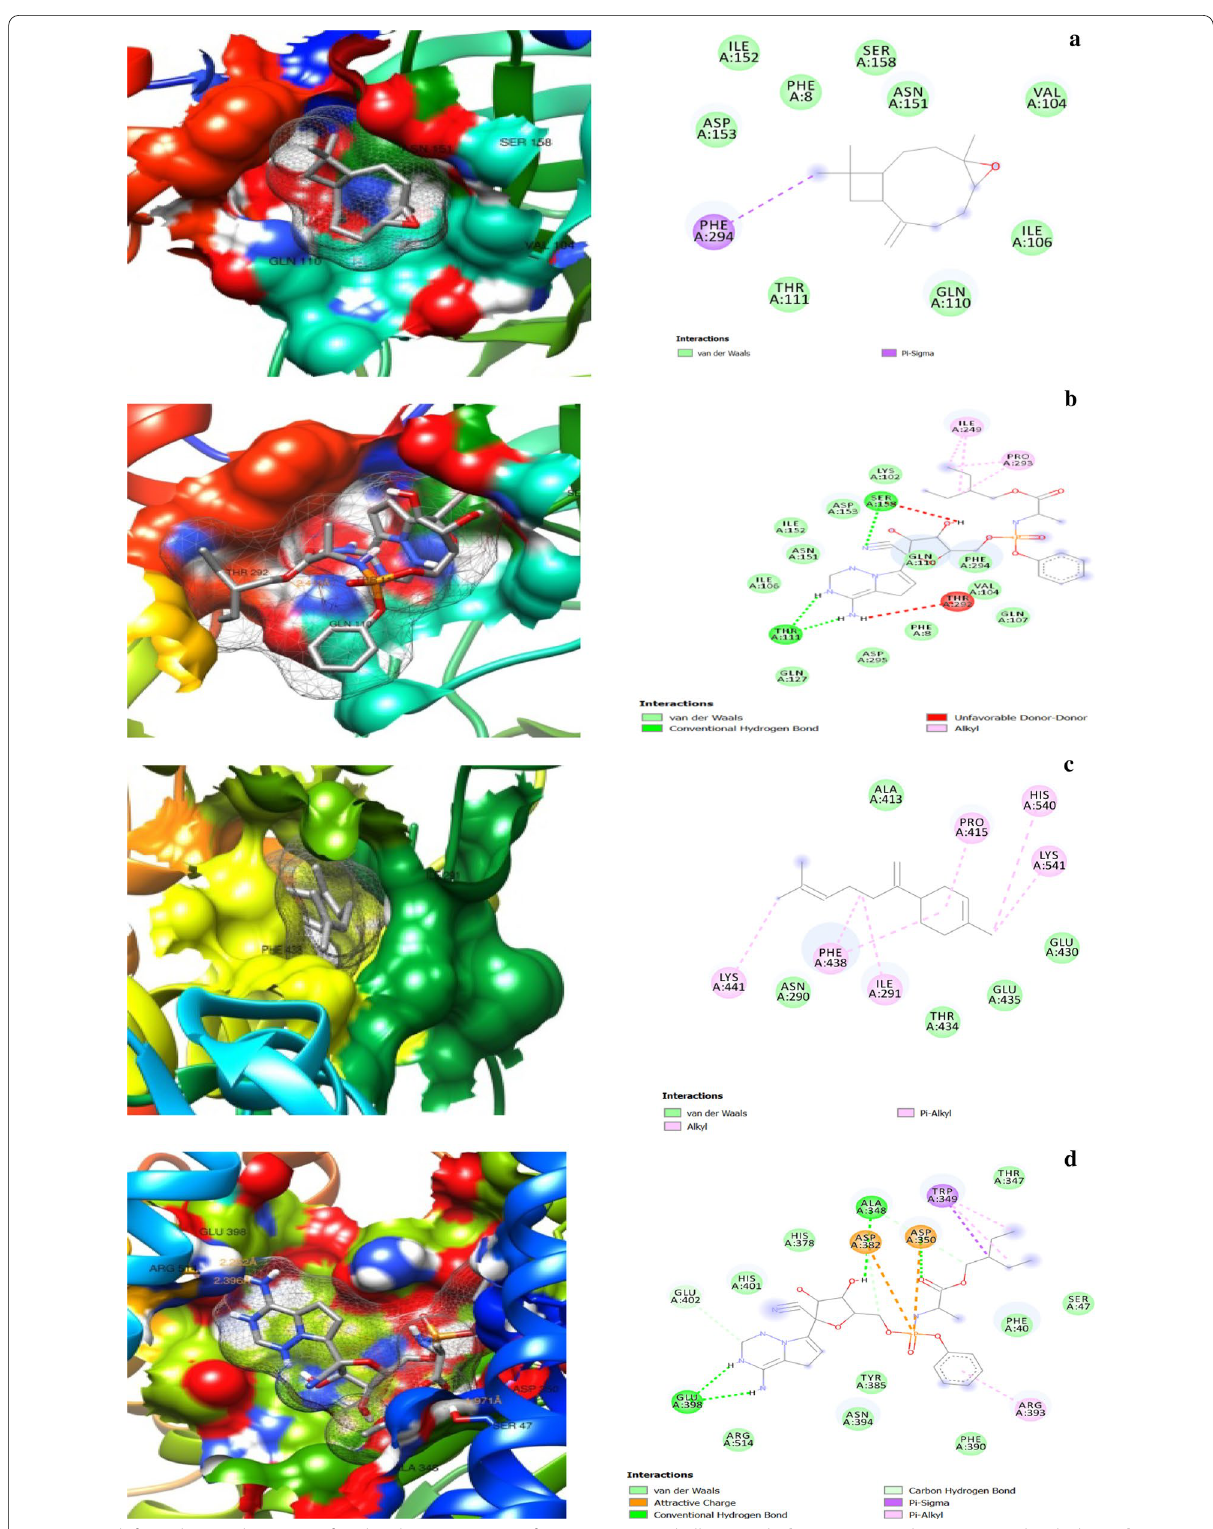
Fig. 5: 3D (left) and 2D (right) views of molecular interactions of a 3CLpro-caryophyllene oxide. b 3CLpro-Remdesivir. c ACE2-bisabolene. d ACE2-Remdesivir. e NSP3-caryophyllene oxide. f NSP3-Remdesivir. g NSP9-caryophyllene oxide. h NSP9-Remdesivir. i RDRP-cryophyllene oxide. j RDRP-Remdesivir. k RP1A-bergamotene. l RP1A-Remdesivir